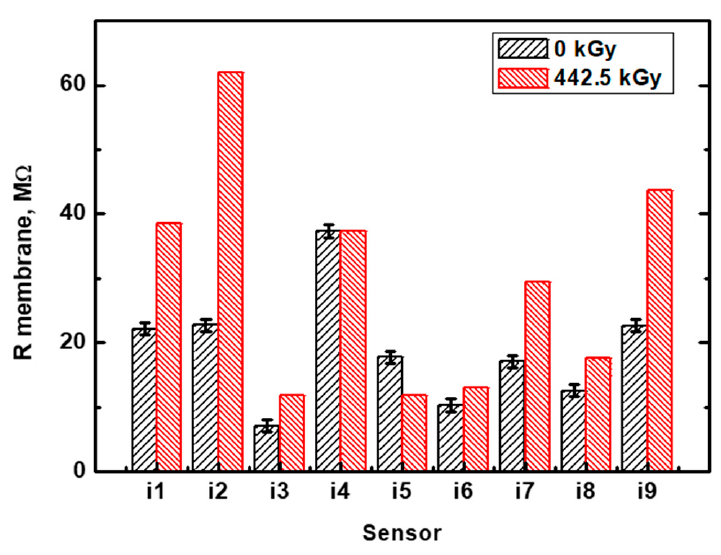
Figure 4. Membrane resistance for control (0 kGy) and irradiated (442.5 kGy) sensor arrays.